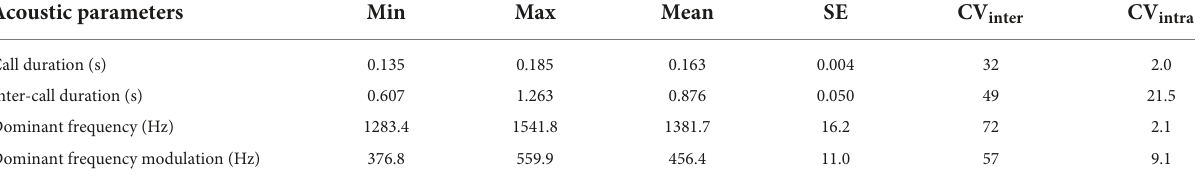
TABLE 1 Descriptive statistics of the acoustic traits of the mating calls in 18 male L. bufonius from Corrientes,